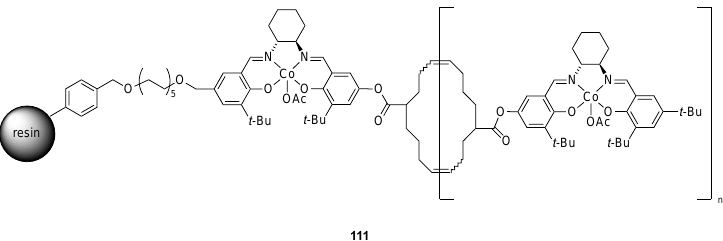
Figure 43. Resin-supported macrocyclic oligosalen catalyst 111 based on oligomer 76 (Figure 31).